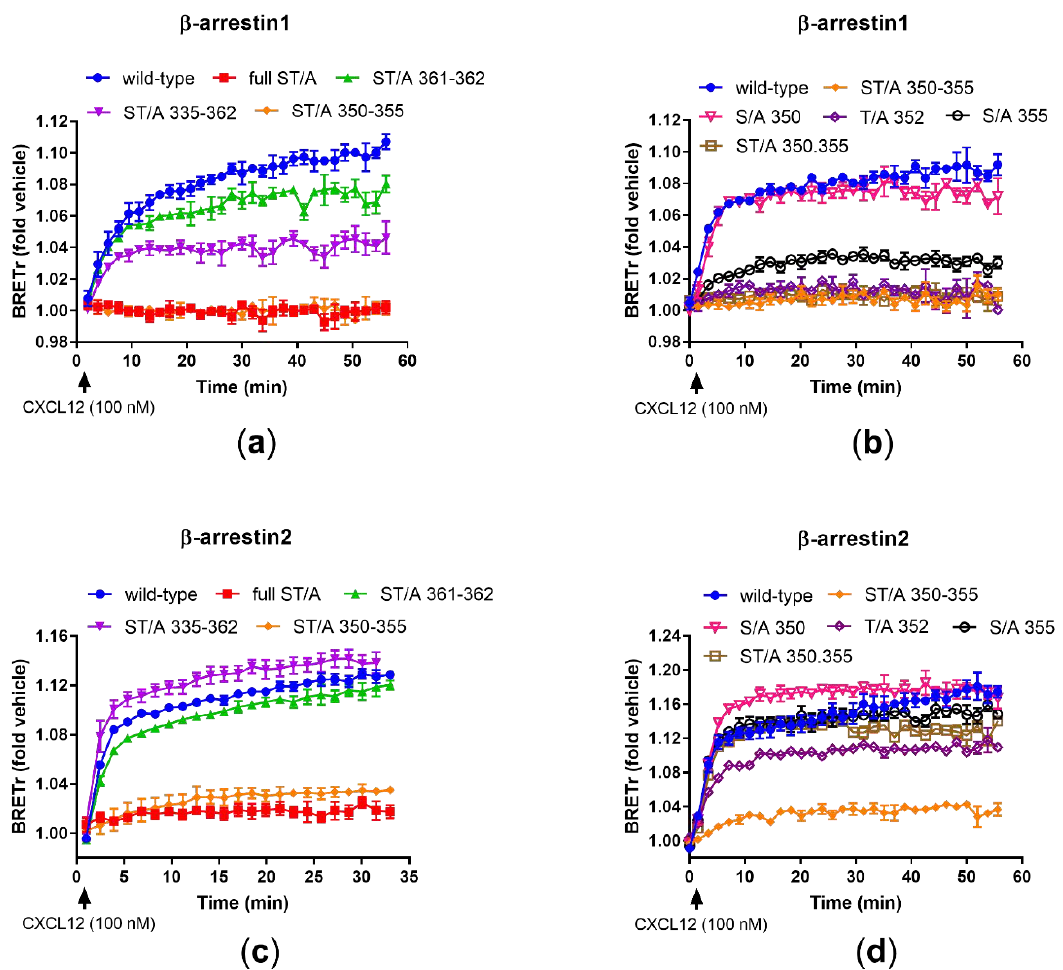
Figure 4. β -arrestin1 and β -arrestin2 recruitment to ACKR3 wild-type and mutant receptors upon CXCL12 stimulation. ( a ) CXCL12-induced β -arrestin1 recruitment to ACKR3 wild-type and different cluster mutant receptors over time as measured by BRET in HEK293T cells; ( b ) CXCL12-induced β -arrestin1 recruitment to ACKR3 wild-type and cluster 2 mutant receptors over time as measured by BRET in HEK293T cells; ( c ) CXCL12-induced β -arrestin2 recruitment to ACKR3 wild-type and different cluster mutant receptors over time as measured by BRET in HEK293T cells; ( d ) CXCL12- induced β -arrestin2 recruitment to ACKR3 wild-type and cluster 2 mutant receptors over time as measured by BRET in HEK293T cells. Representative curves of three independent experiments with triplicates shown as mean ±